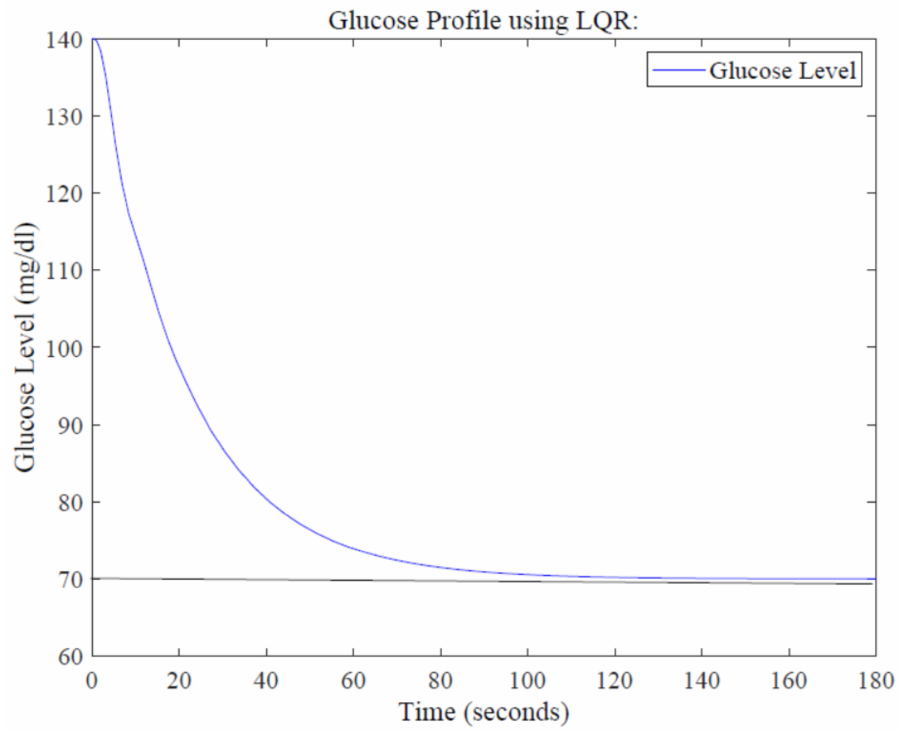
Figure 10. Glucose profile using the LQR